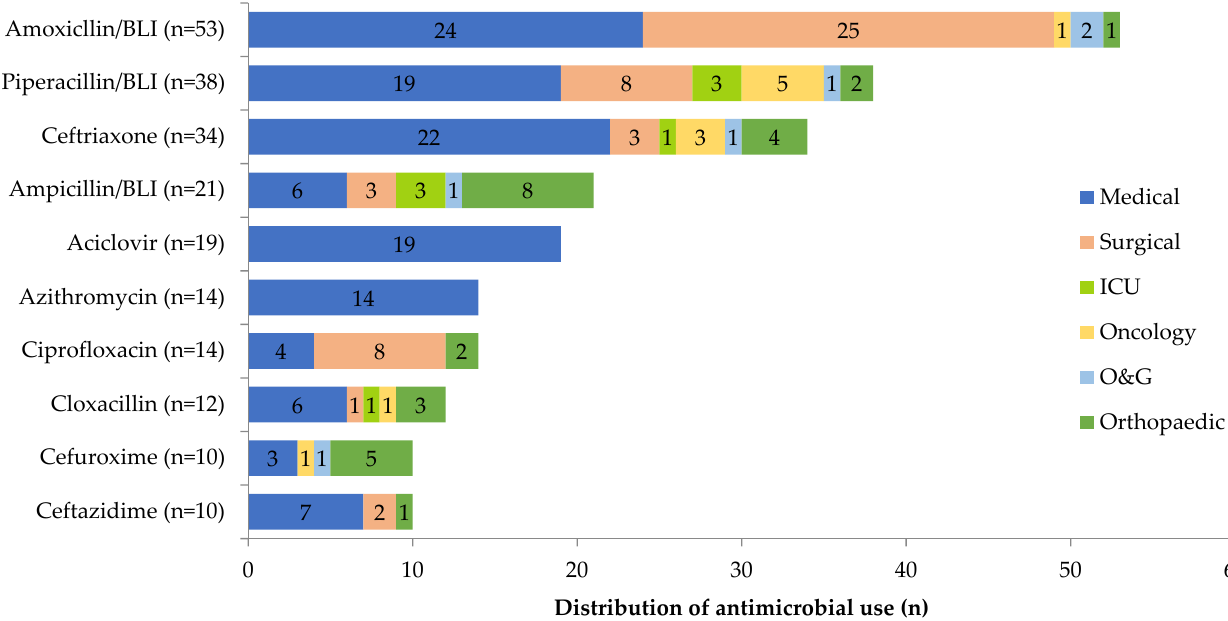
Figure 2. Distribution of 10 most prescribed antimicrobials in various units. The total number of prescriptions is displayed next to each antimicrobial name. BLI: β -lactamase inhibitor. Table 2. Quality indicators for antimicrobial prescriptions ( n = 357).